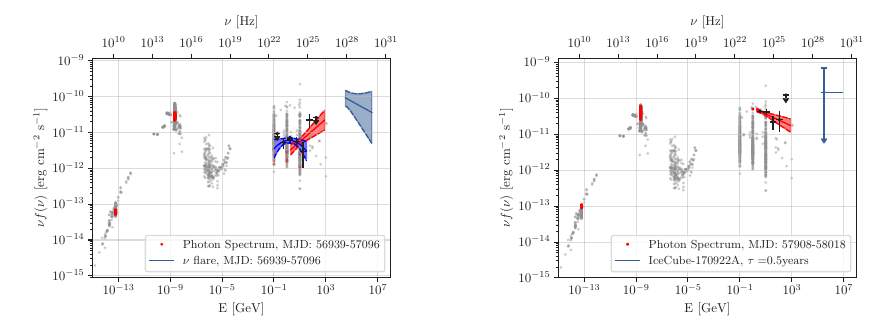
Figure 4. Left : The hybrid SED of electromagnetic emission and neutrinos during the period of the neutrino flare. Archival and time simultaneous data are shown in grey and color, respectively. The red band shows the γ -ray spectrum for neutrino energies above 2 GeV, while the blue band shows a fit to the data between 100MeV and 30GeV when fixing the spectrum to the 9.5 year Fermi -LAT best-fit shape and only leaving the normalization free. Right : The same as the left plot around the time of the Figure 3. Left : The 158 days, (fixed-binning) γ -ray light curve of TXS 0506 + 056 above 2 GeV. The neutrino alert. As there is only one event observed we can only place an upper limit for the neutrino kernel density estimate of the flux and spectral index distribution are shown as black lines on the plots flux derived from Poisson statistics for half a year of IceCube exposure. In both plots the SED points on the top- and bottom-right, respectively. Right : An adaptive bin light curve for PKS 0502 + 049 above are EBL de-absorbed using the model of Emin = 214 MeV (see [11] for technical explanation). Note that we go down to lower energies since the PKS 0502 + 049 strongly dominates in this energy regime. Going to higher energies it quickly softens above 934 MeV [10]. The grey shaded area shows the time windows of an increased photon flux. In both plots the blue band indicates the time window of the neutrino flare.